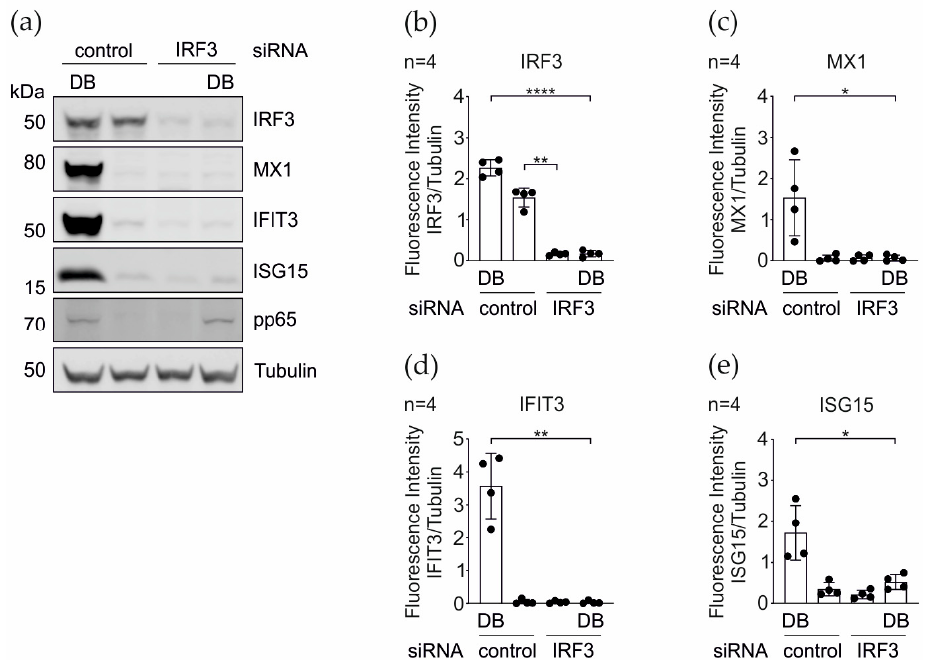
Figure 6. DB-mediated induction of the IRG-expression in the dependence on IRF3. ( a ) Western blot analysis of the IRF3, MX1, IFIT3, and ISG15 protein expression levels in HFFs that were transfected with a siRNA against IRF3 or with a control siRNA and treated with 20 μ g of the UV-inactivated TR- ∆ GFP DBs. Tubulin levels were used as a loading control and the pp65 levels as the DB internalization control. ( b – e ) Quantification of the protein levels in ( a ). The ratio of the measured fluorescence intensity of each protein band to the corresponding tubulin band was calculated. The values of four independent experiments were plotted. Comparisons between groups were calculated using an unpaired t-test with Welch´s correction. * p < 0.05; ** p < 0.01; **** p < 0.0001.